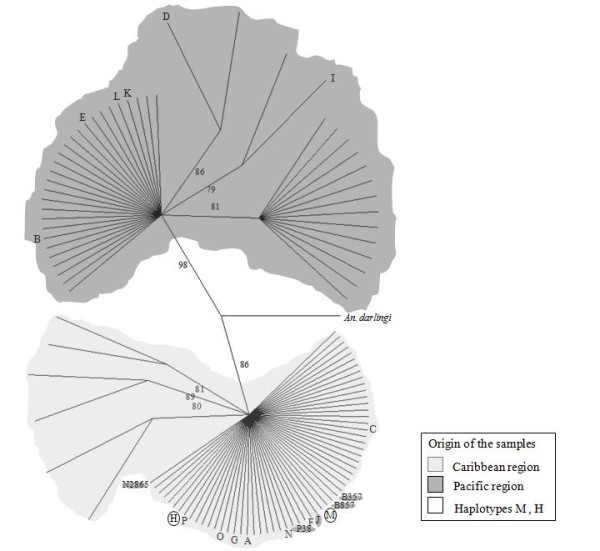
Neighbour-Joining tree based on 112 haplotypes from 1058 bp of the COI gene sequenced from 220 specimens of An. albimanus. The percentage of trees in which the associated haplotypes clustered together in the bootstrap test (1,000 replicates) is shown next to the branches, retaining only groups with frequency ≥75%. Shared haplotypes (M, H) from the Caribbean and Pacific populations are represented in the tree.